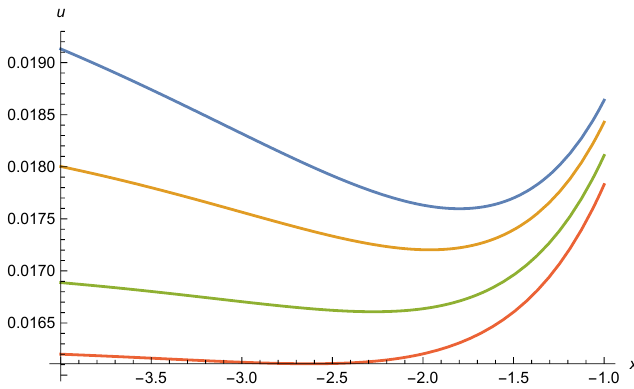
Figure 10. Effective potential u in presence of a nonminimal coupling ξ to gravity, in function of x = ln ( ˜ ρ ) . Parameters are ξ = 0.1, N eff = 10. Different curves correspond to different values of w 0 = 0.038, 0.042, 0.05, and 0.06, with corresponding A 0 given by 2.74, 1.64, 1.0, and 0.68, from top to bottom. We choose as initial condition u ( x = 0 ) = 0.03. A local minimum occurs near x = −